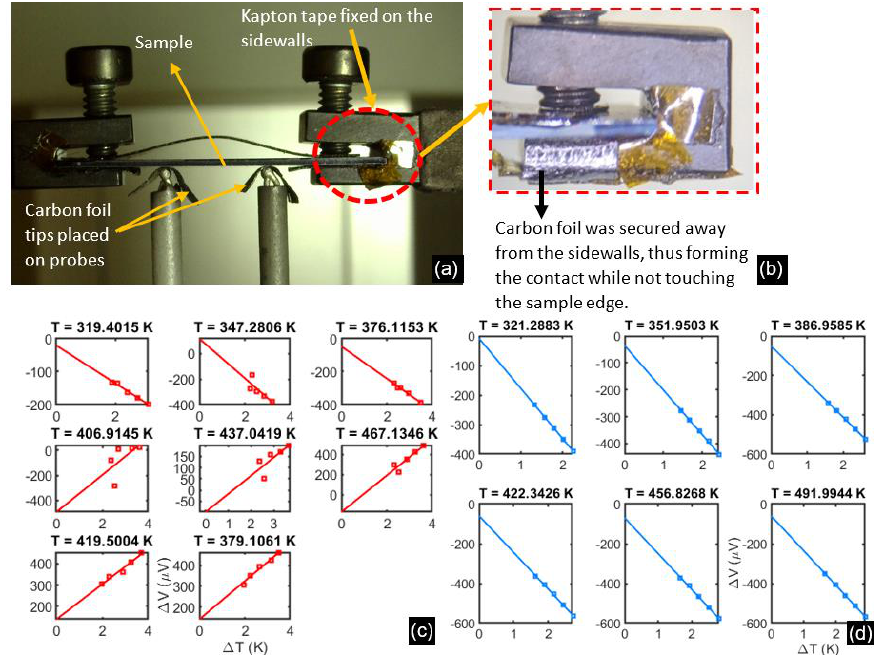
Figure 5. ( a ) Thin film samples are placed upside down and secured by screws on the end supports. The left support heats up, creating a temperature gradient measured by the thermocouple probes shown. These probes also document the Seebeck voltage across the probe distance, which was ~3.5 mm. ( b ) The inset shows that the carbon foil and Kaptan tape were added to prevent substrate conduction. ( c ) Noisy and inconclusive voltage-temperature gradients were measured before modification of the setup. ( d ) Repeatable and good quality data with the upgraded setup. Both ( c , d ) were measured on thin films deposited on Si/SiO 2 substrates. Table 3. Thermoelectric properties from the set of samples with optimum pellet compositions and bake times but deposited with different adhesion layers on three